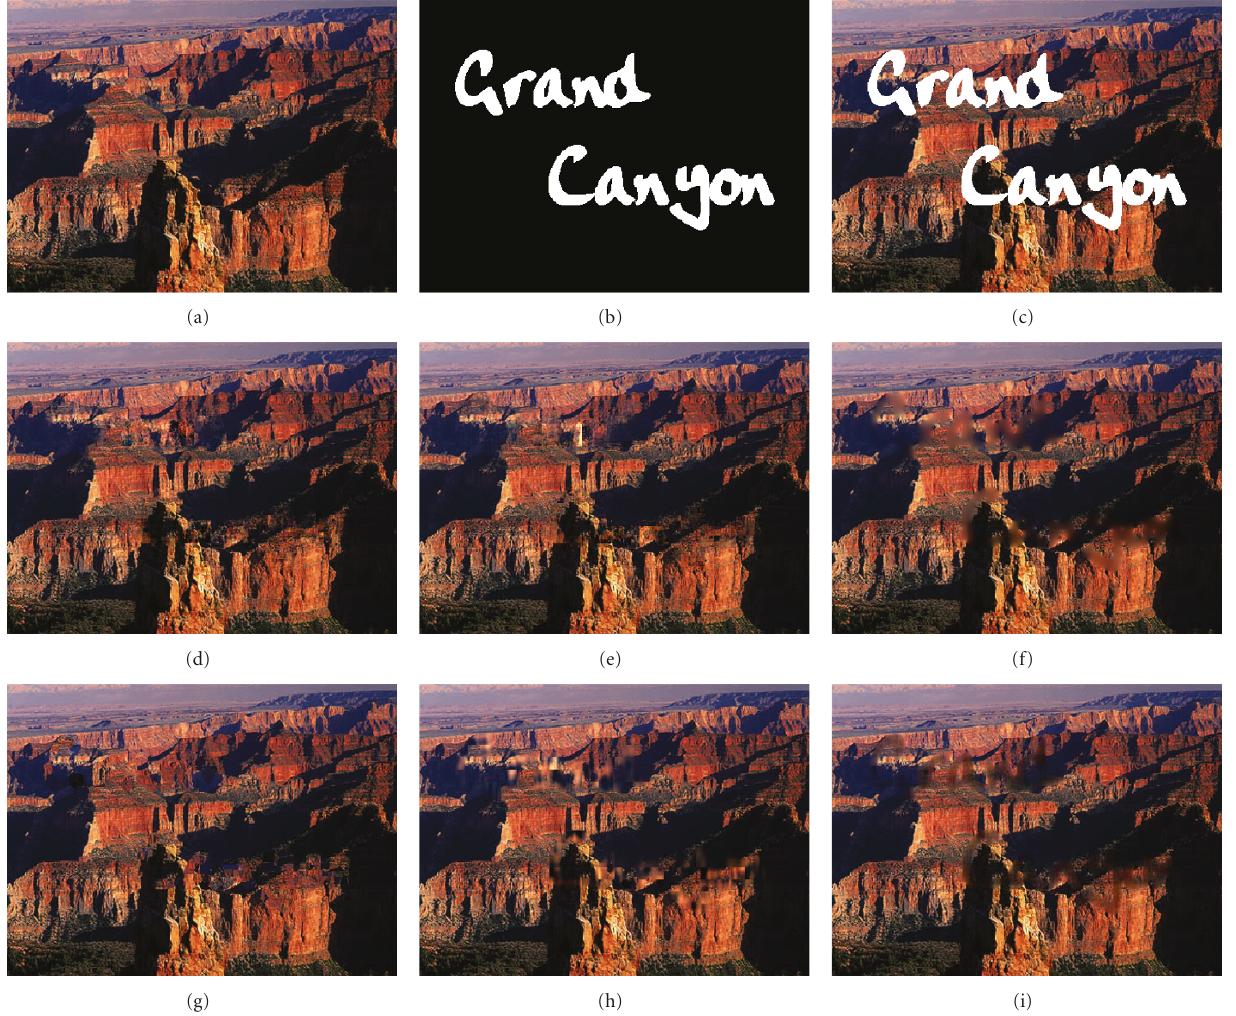
Figure 2: (a) Original image (480 × 359 pixels, 24-bit color levels). (b) Flag image whose white regions correspond to missing areas. (c) Corrupted image including text regions (8.9% loss), (d) Reconstructed image by the proposed method. (e) Reconstructed image by the method based on the random selection. (f) Reconstructed image by the method which utilizes the MSE instead of the SSIM index. (g) Reconstructed image by the conventional method [11]. (h) Reconstructed image by the conventional method [13]. (i) Reconstructed image by the conventional method